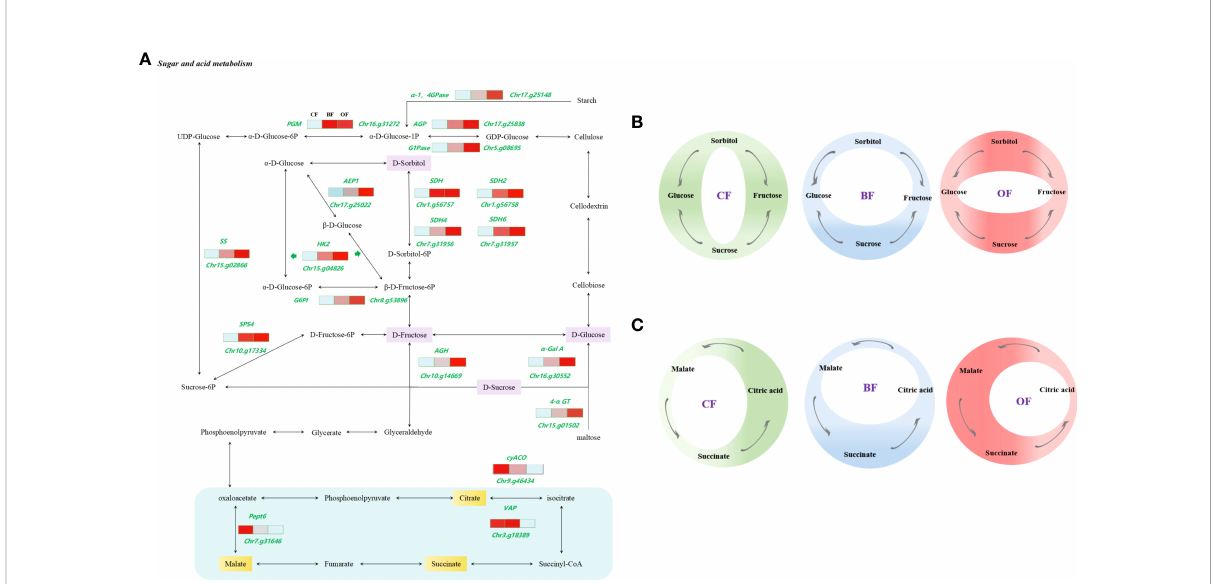
FIGURE 7 Relationship between KEGG pathway with sugar/organic acid metabolism. (A) Expression pro fi les of differentially expressed genes (DEGs) involved in sugar and organic acid metabolism in pear fruit from KEGG pathways. Enzyme names are shown along with their expression patterns at different fertilization treatments. Grids represent the expression patterns of genes shown as FPKM values: CF, BF, OF. (B, C) Effect of different fertilizers on sugar and organic acid metabolism transformations in fruits. The circle area represents the extent of sugar